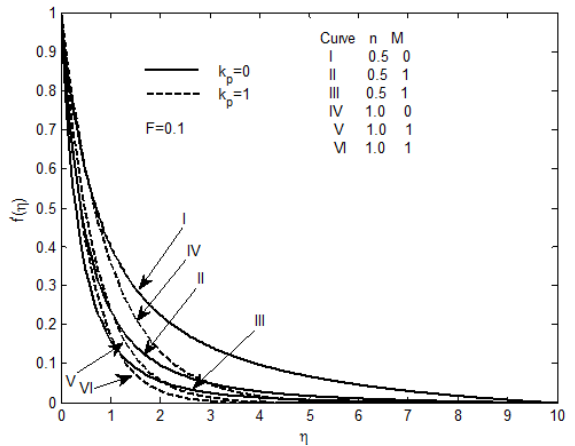
Figure 6: Temperature profiles (PST